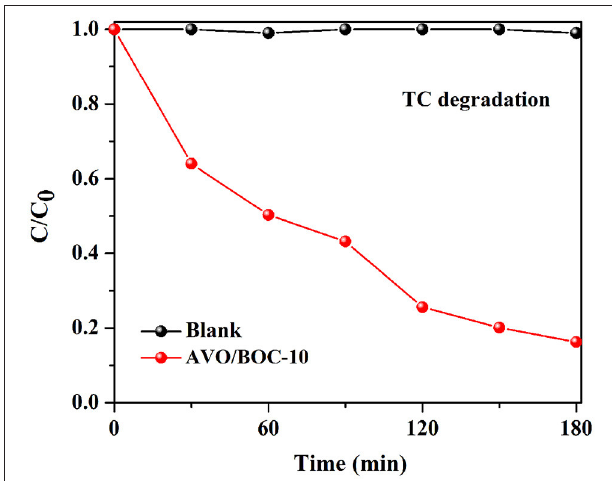
FIGURE 6 | Photocatalytic degradation efficiency of TC over AVO/BOC-10.